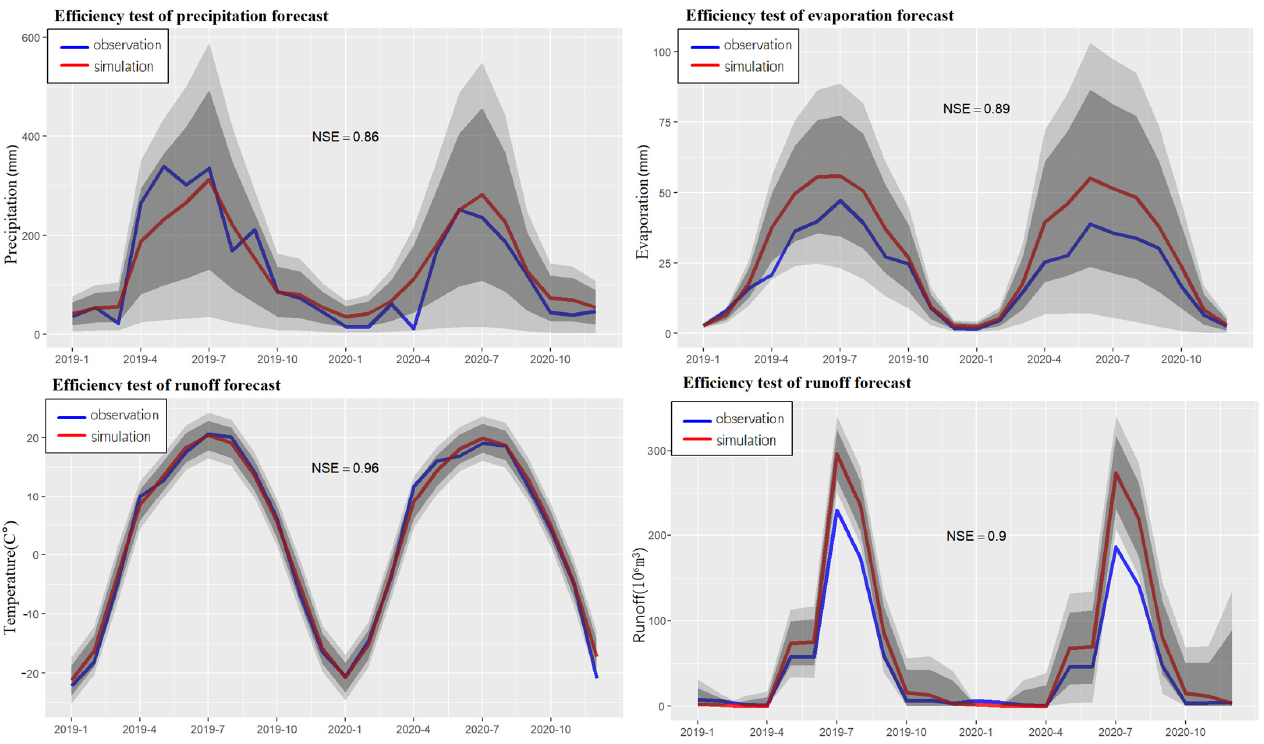
Figure 5. Predictions and confidence intervals at two levels (0.8 and 0.95) with